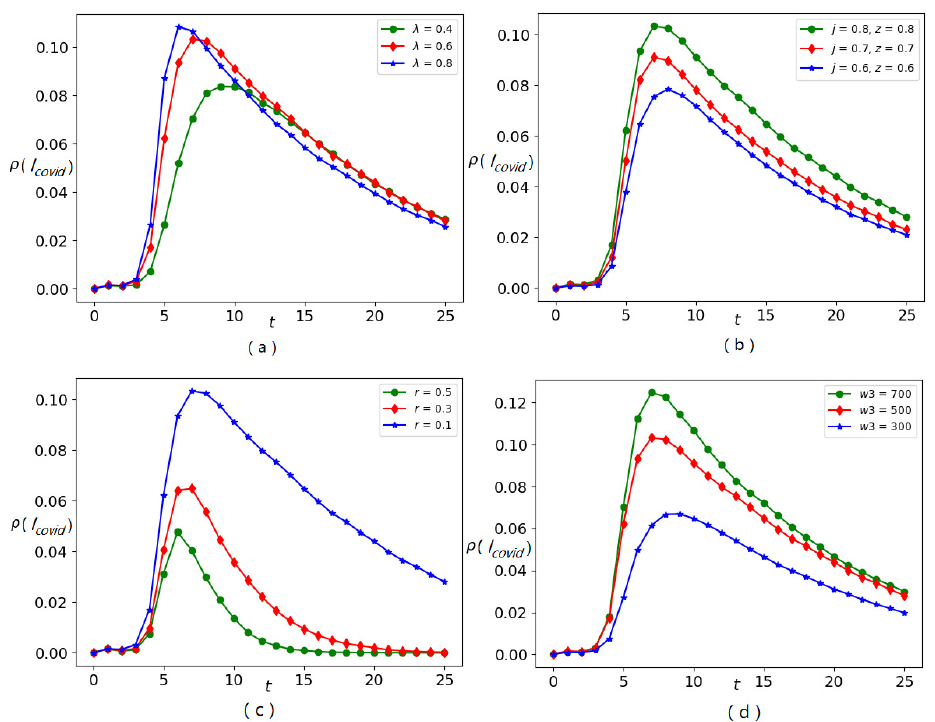
Figure 10. The influence of different factors on the spread of the new discovery when a new discovery is spread in the COVID-19 field. ( a ) The density change curve of I covid with time when λ is different and the other parameters remain unchanged as m = 50, λ 1 = 0.3, r = 0.1, λ h = 0.05, r h = 0.15, j = 0.8, z = 0.8, and u = 0.05, w 3 = 500. ( b ) The density change curve of I covid with time when j and z are different and the other parameters remain unchanged as m = 50, λ = 0.6, λ 1 = 0.3, r = 0.1, λ h = 0.05, r h = 0.15, u = 0.05, and w 3 = 500. ( c ) The density change curve of I covid with time when r is different and the other parameters remain unchanged as m = 50, λ = 0.6, λ 1 = 0.3, λ h = 0.05, r h = 0.15, j = 0.8, z = 0.8, u = 0.05, and w 3 = 500. ( d ) The density change curve of I covid with time when w 3 is different and the other parameters remain unchanged as m = 50, λ = 0.6, λ 1 = 0.3, r = 0.1, λ h = 0.05, r h = 0.15, j = 0.8, z = 0.8, and u = 0.05. The ordinate ρ ( I covid ) in ( a – d ) represents the proportion of articles containing this new discovery in the COVID-19 field to all articles in the network.